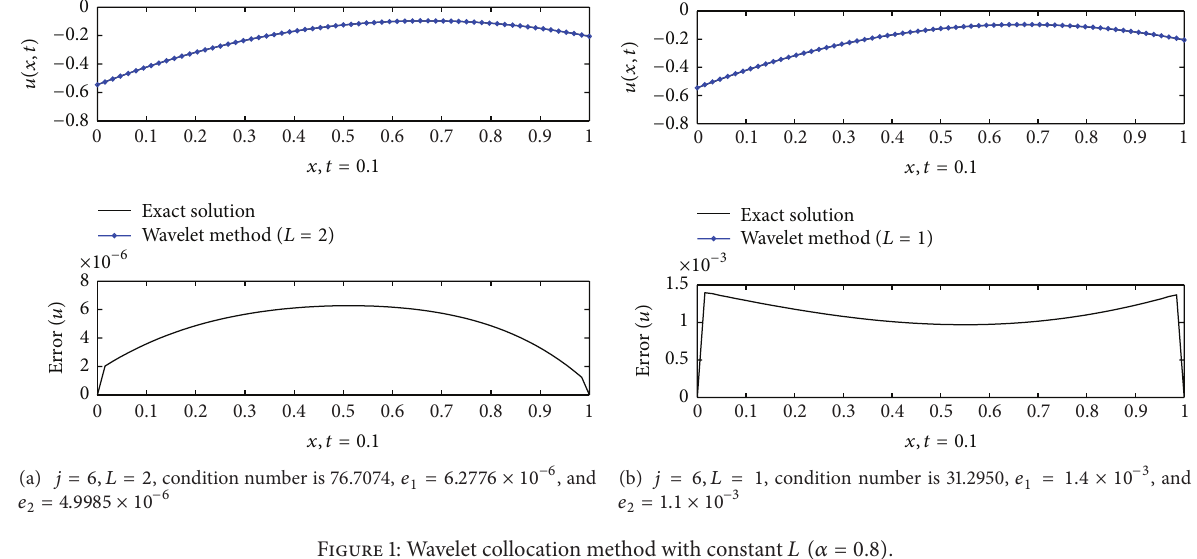
Figure 1: Wavelet collocation method with constant 𝐿 (𝛼 = 0.8) .